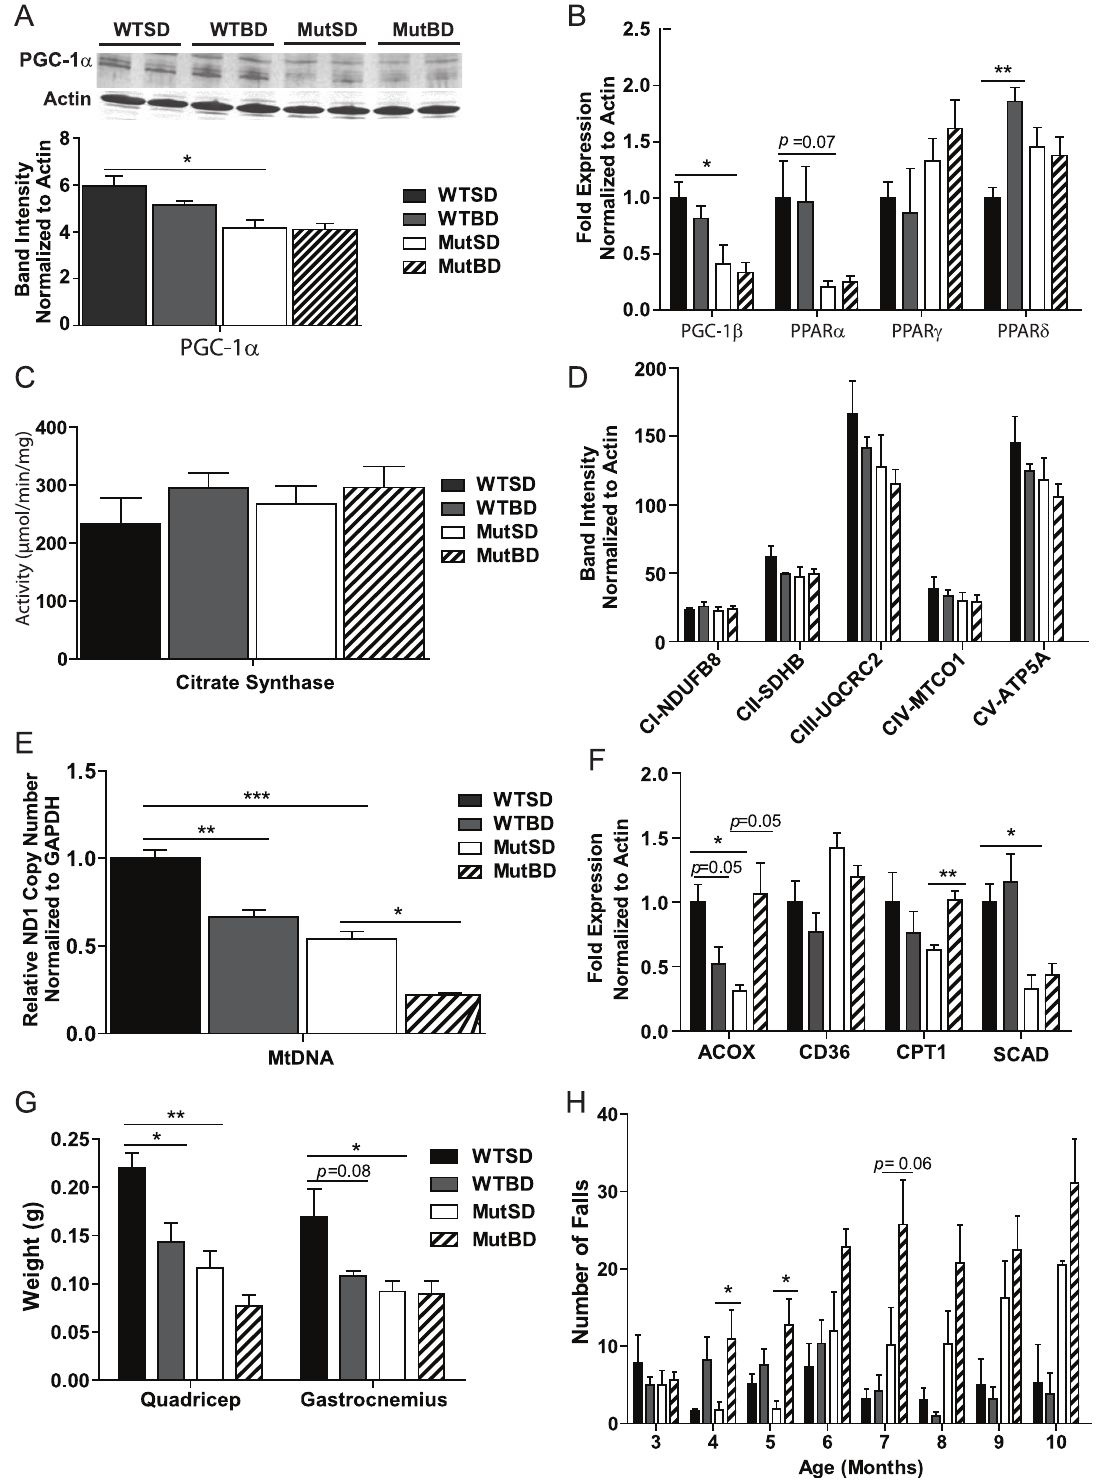
Figure 4. The effect of bezafibrate on the skeletal muscle of Mut and WT mice. (A) Western blot of PGC-1 a and loading control actin in total quadricep homogenate from 10 month-old mice and quantification of PGC-1 a band intensity normalized to actin (n=4/group). (B) Gene expression of PGC-1 b and PPARs in the quadricep of 10 month-old mice normalized to actin (n=4/group). (C) Citrate synthase activity in the total quadricep homogenate from 10 month-old mice (n=4/group). (D) Quantification of western blot of mitochondrial proteins in the total homogenate from the quadricep of 10 month-old mice (n=4/group). NADH dehydrogenase (ubiquinone) 1 b subcomplex subunit 8 (NDUFB8; subunit of complex I), succinate dehydrogenase subunit B (SDHB; subunits of complex II), ubiquinol-cytochrome c reductase core protein 2 (UQCRC2; subunit of complex III), mitochondrial cytochrome c oxidase subunit 1 (MTCO1; subunit of complex IV) and ATP synthase subunit 5 a (ATP5A; subunit of complex V) (E)